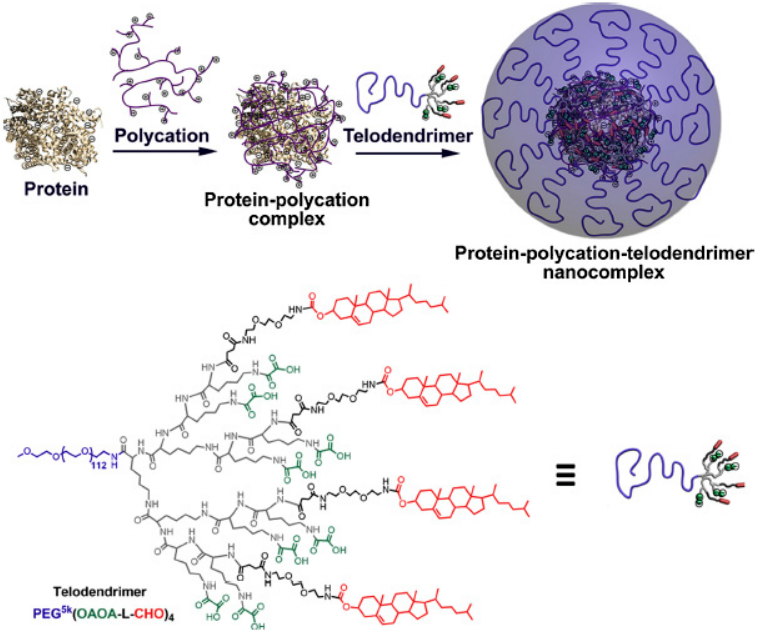
Figure 6. Telodendrimer and the methodology to construct protein-polycation-telodendrimer nanocomplexes. Reprinted with permission from [171]. Copyright 2018 Elsevier.